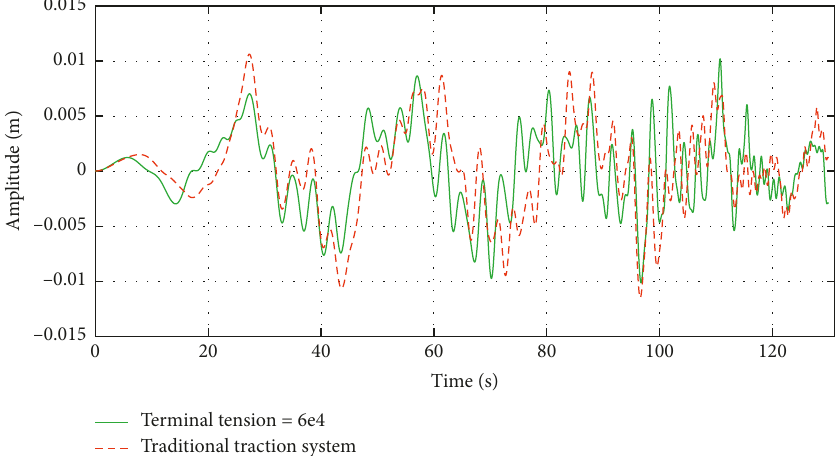
Figure 17: Comparison of transverse vibration displacements at the conveyance.